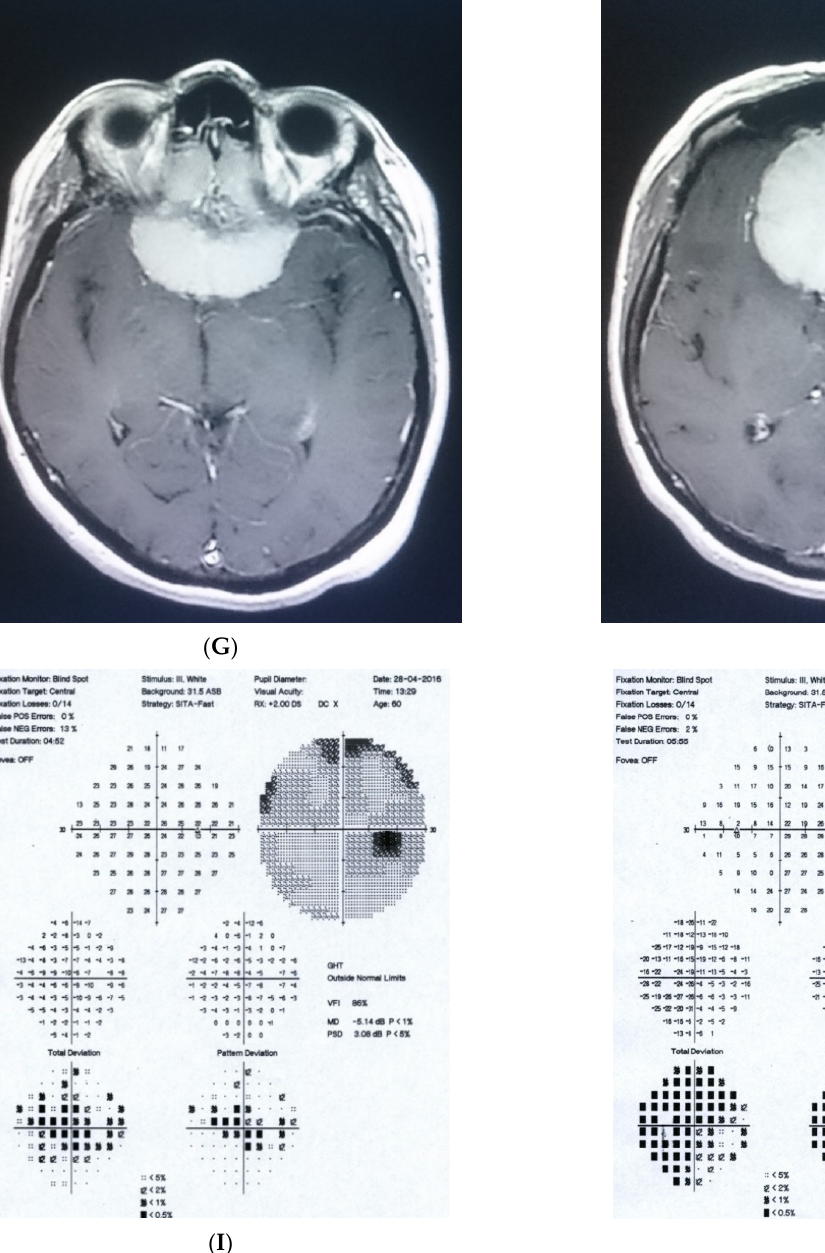
Figure 1. A 60-year-old woman with olfactory groove meningioma. ( A ) Optic disc right eye. ( B ) Optic disc left eye. ( C ) Visual field right eye 04.2015, initial visit. ( D ) Visual field left eye 04.2015, initial visit. ( E ) Visual field right eye 09.2015, showing rapid progression. ( F ) Visual field left eye 09.2015. ( G , H ) MRI scans with visible olfactory groove meningioma. ( I ) Visual field right eye 04.2016, after neurosurgical procedure. ( J ) Visual field left eye 04.2016 after neurosurgical procedure.